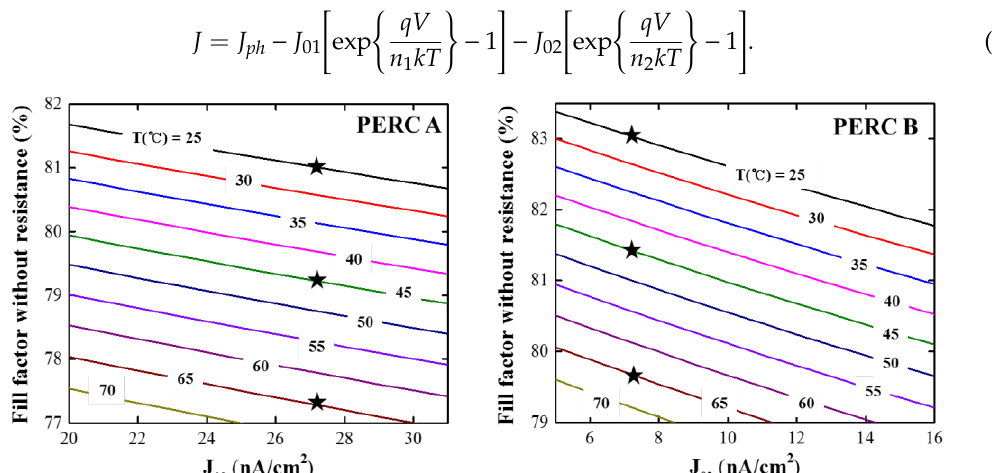
Figure 8. Theoretical calculation of FF 0 as function of the J 02 (25 °C). The star marks are the FF 0 value extracted from fill factor loss analysis (Table 2).